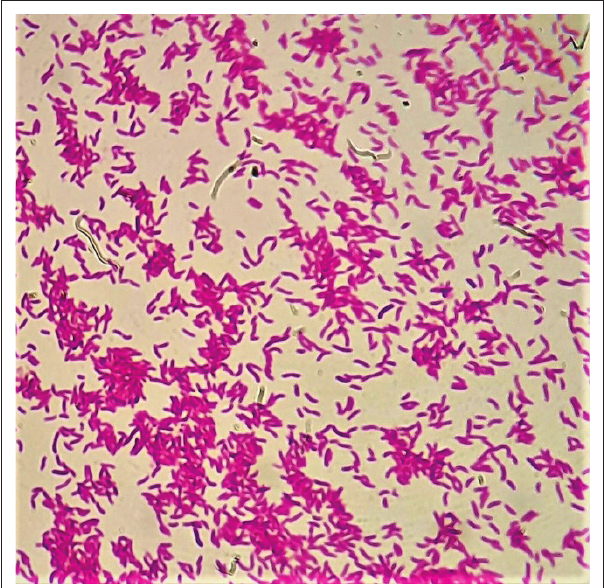
FIGURE 1: Gram stain with comma-shaped Gram-negative bacilli suggestive of Vibrio